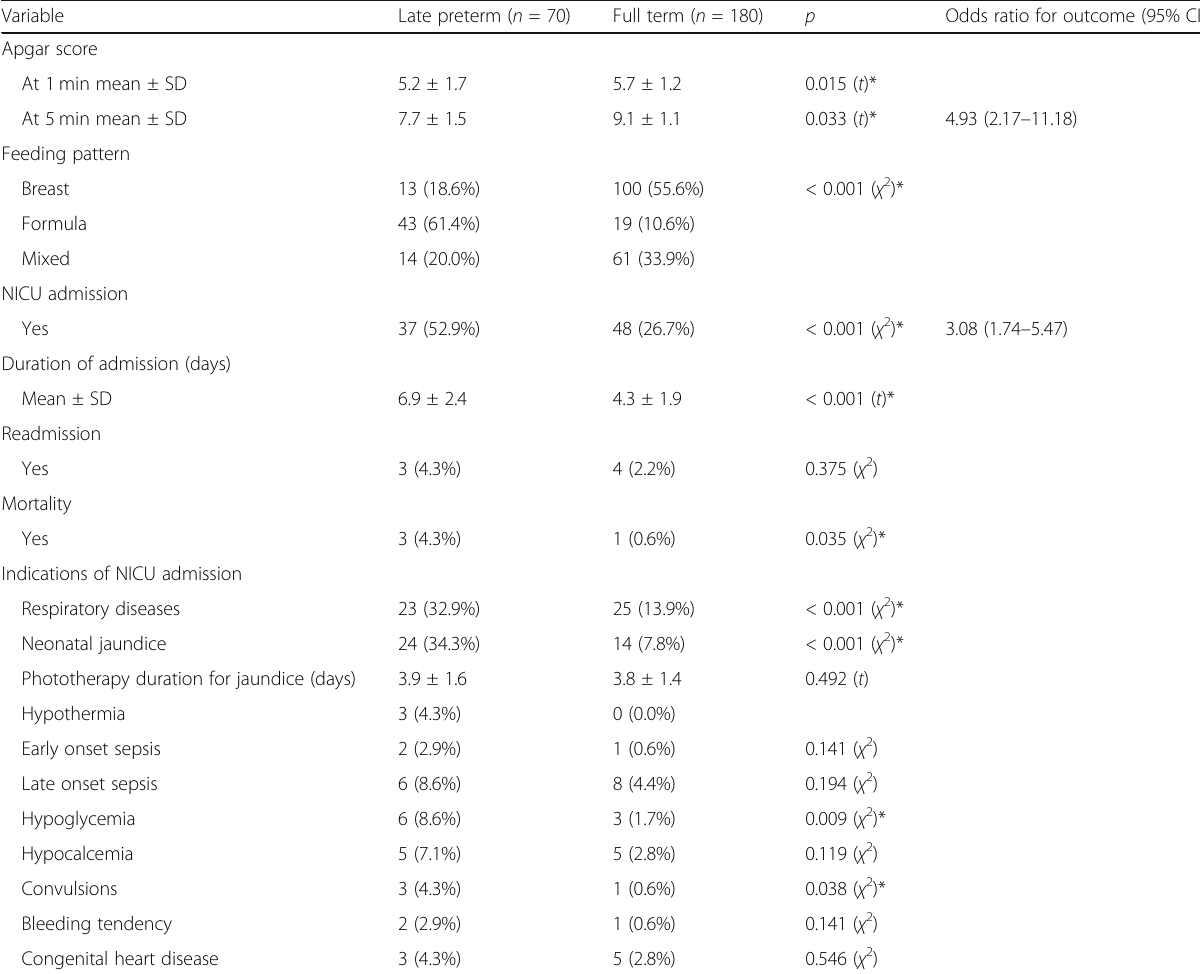
Table 3 Outcome of the studied neonates ( n = 250)